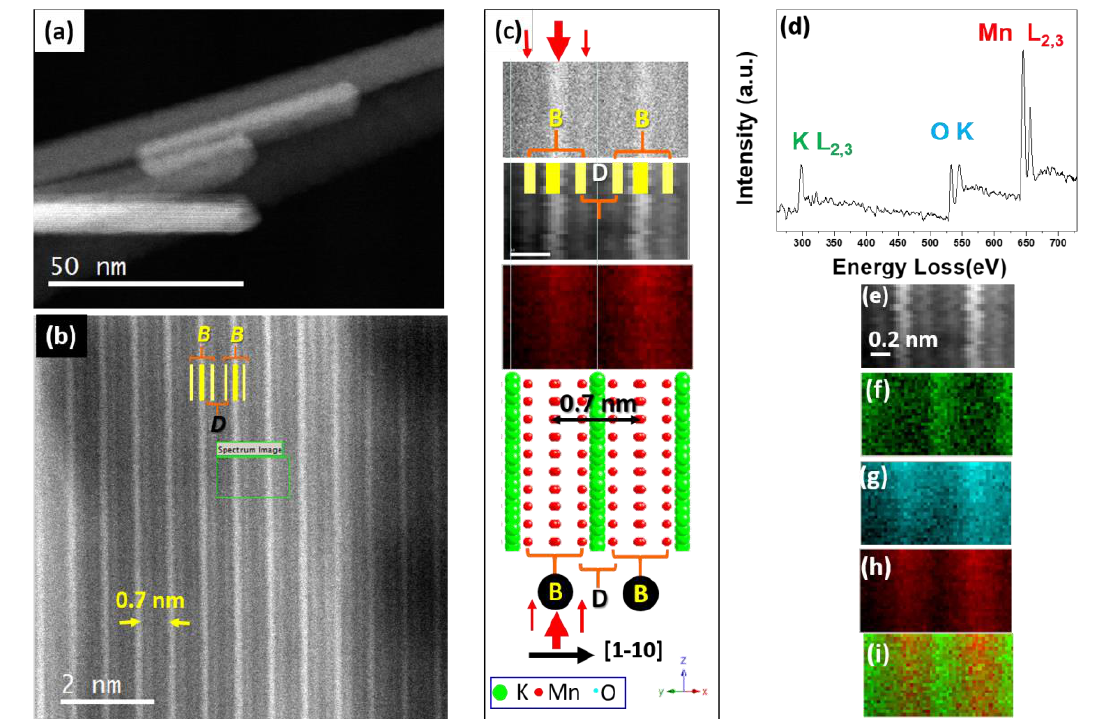
Nanomaterials 2021 , 11 , x FOR PEER REVIEW 15 of 21 Figure 9. ( a ) Low-magnification STEM-HAADF image of several K 0 . 12 MnO 2 nanowires; ( b ) HAADF image detail of a single nanowire; ( c ) from top to bottom: EELS spectra; online HAADF image, Mn chemical map; schematic model along the [110] direction; ( d )sum spectra corresponding to the area framed in green in part b; ( e ) online HAADF image; ( f ) K-L 2,3 chemical map; ( g ) O-K chemical map; ( h ) Mn-L 2,3 ; ( i ) K and Mn maps overlapped.